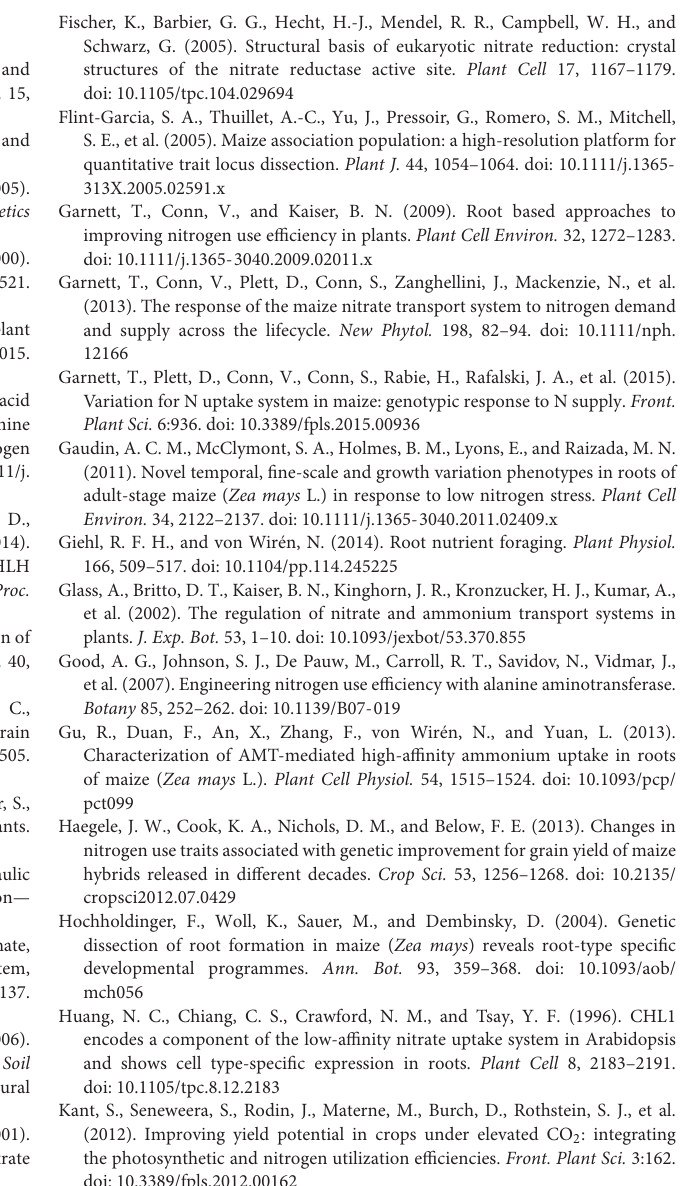
FIGURE S1 | Expression of glutamine synthetase genes ( ZmGLN ) in roots of B73 (white) and F44 (black). Values are means ( ± SE) from three individual plants. Similar results were obtained in another independent experiment. FIGURE S2 | Expression of ZmNRT3.1A (A) and ZmNRT2.1 (B) in B73 (white) and F44 (black) in the primary (PR), seminal (SR) and crown (CR) root tissues. Values are means ( ± SE) from 4 to 5 individual plants. Different letters indicate significant differences among means at P < 0.05 (ANOVA).